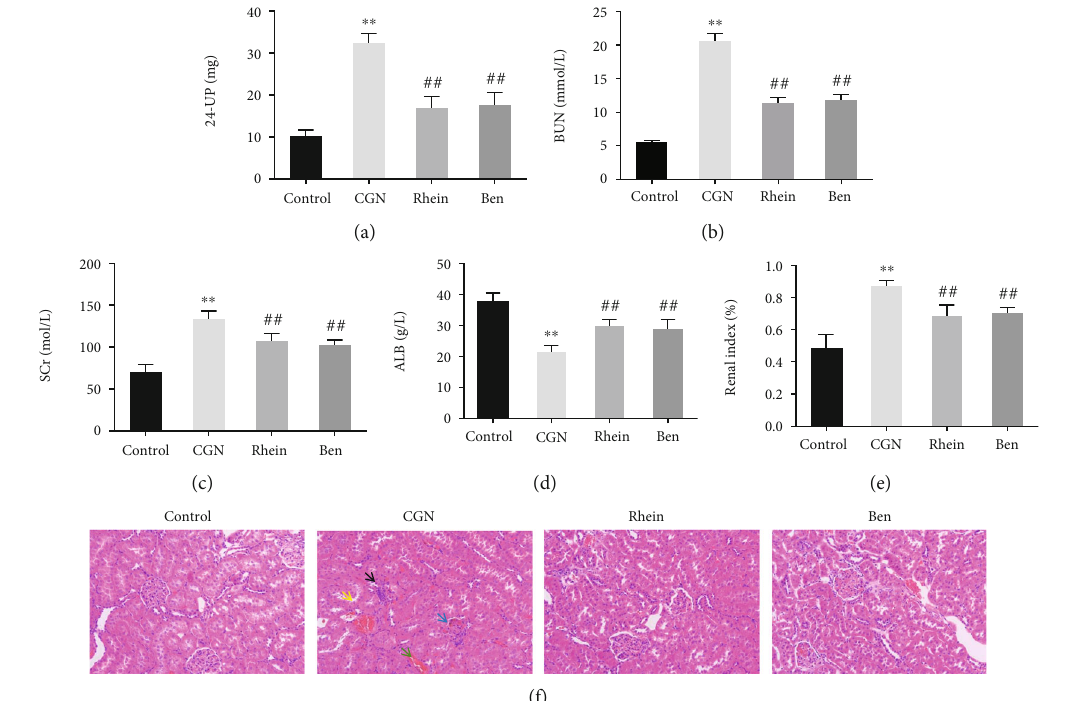
Figure 1: E ff ects of rhein on renal function in CGN rats. (a – d) Biochemical detection of 24h urinary protein (a), blood urea nitrogen (BUN) (b), serum creatinine (SCr) (c), and albumin (ALB) (d) in each group of rats. (e) Results of renal index of rats in each group ( n = 6 ). (f) H&E staining was applied to observe the renal injury of rats in each group. Black arrows expressed in fl ammatory cell in fi ltrates; yellow arrow displayed tubular epithelial cell detachment; blue arrow indicated glomerular congestion; and green arrows suggested renal interstitial congestion. ∗∗ p < 0 : 01 , control group; ## p < 0 : 01 , CGN